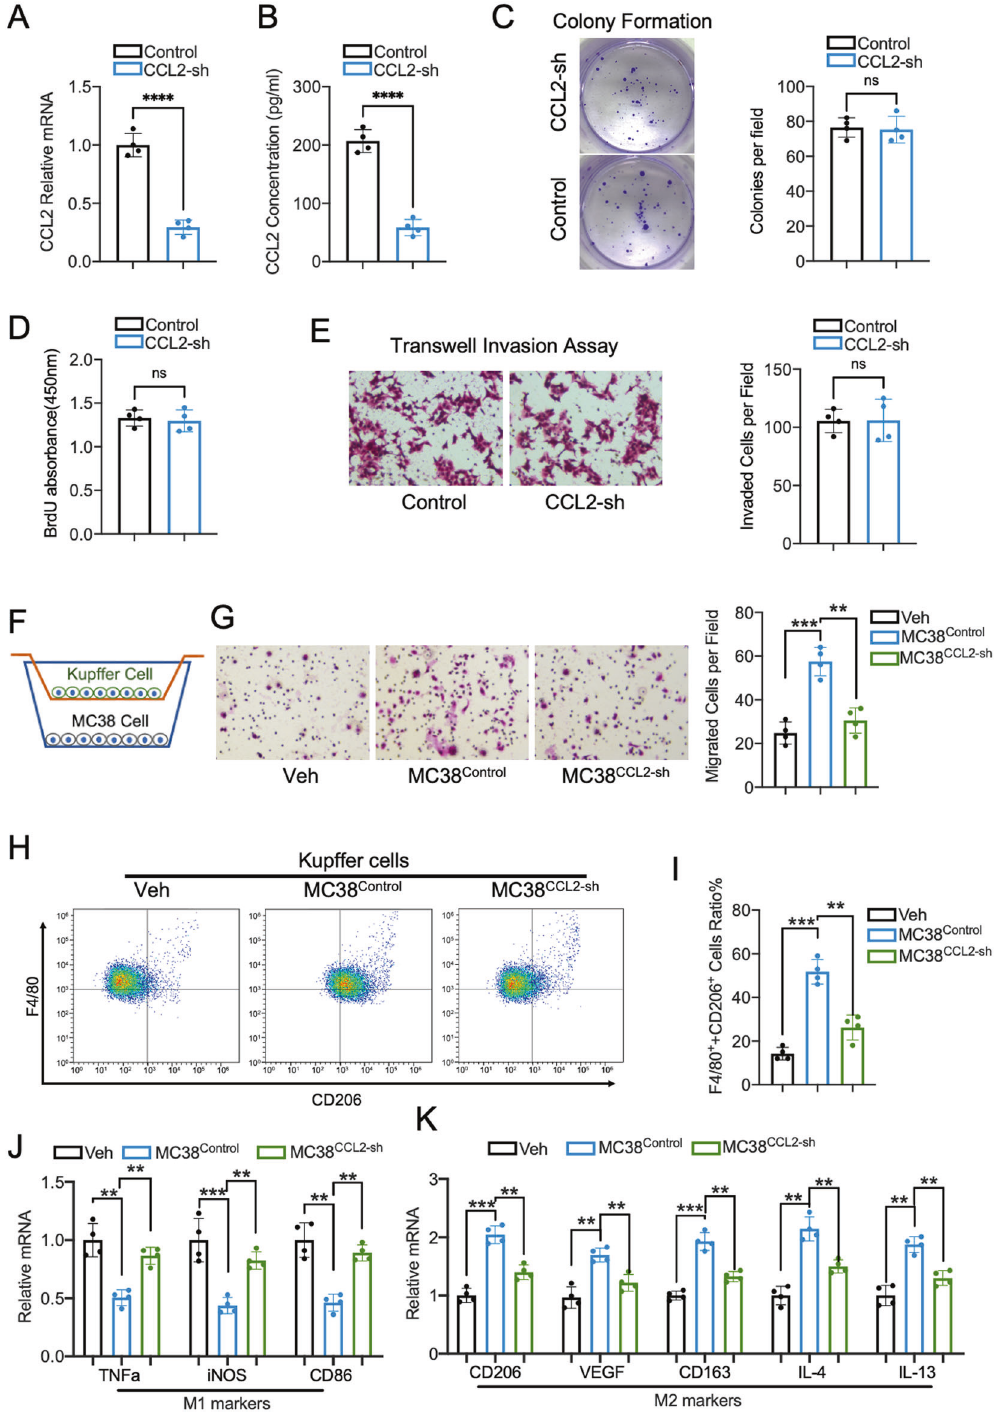
Fig. 6 Loss of CCL2 impairs MC38 induced Kupffer cell migration and M2 polarization. A TCF4 mRNA expression was evaluated in MC38 cells with TCF4-shRNA stable transfection. B CCL2 protein concentrations in the culture medium of MC38Control and MC38CCL2-sh cells were evaluated by ELISA. n = 4, per group. C Representative images and quanti fi cation of colony numbers in MC38Control and MC38TCF4-sh cells. n = 4, per group. D BrdU incorporation assay of MC38 cells. n = 4, per group. E Representative Images and quanti fi cation of Matrigel-transwell invasion assay for MC38Control and MC38TCF4-sh cells. n = 4, per group; fi ve fi elds were counted per sample. F Schematic diagram of the Kupffer cell and MC38 cell coculture system. G Transwell migration assay and quanti fi cation of the migrated Kupffer cells cocultured with indicated MC38 cells or control. n = 4, per group; fi ve fi elds were counted per sample. H FACS analysis for F4/80 and CD206 of Kupffer cells cocultured with indicated cells or control. I Quanti fi cation of F4/80 + CD206 + cells ratio from three groups. n = 4 per group. J Q-PCR results of M1 macrophage markers expression in Kupffer cells. K . M2 macrophage markers mRNA expression in Kupffer cells cocultured with MC38 cells. Data are means ± SEM. * P < 0.05, ** P < 0.01, *** P < 0.005, **** P <